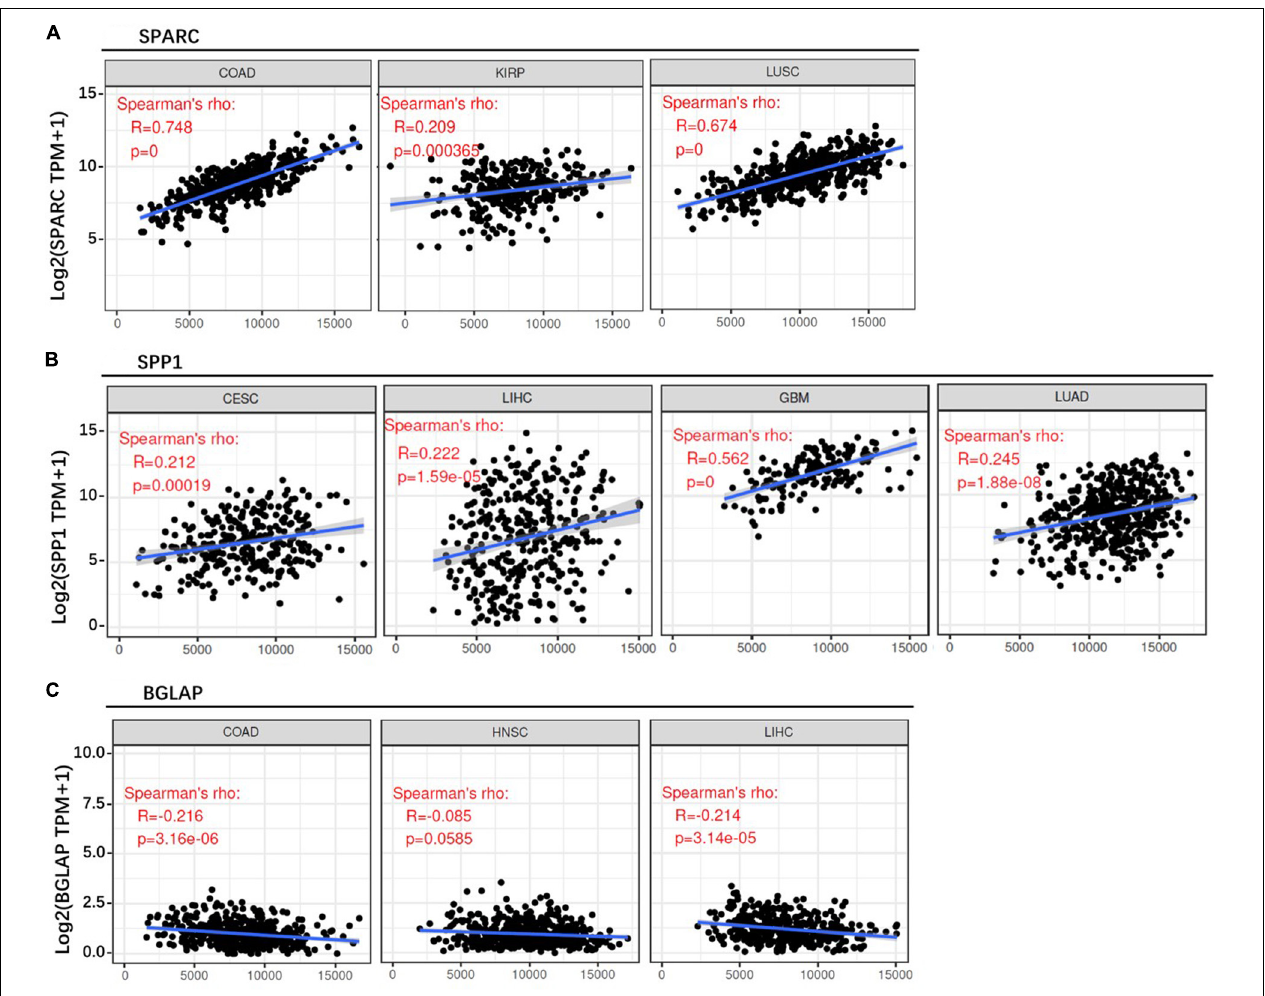
FIGURE 6 | Correlation between osteomimicry and ESTIMATE score in the cancer types in which osteomimicry indicated unfavorable survival. SPARC (A) and SPP1 (B) expression were positively correlated to ESTIMATE score, but BGLAP (C) expression was weakly and negatively correlated to ESTIMATE score. p < 0.05 represents that difference is statistically